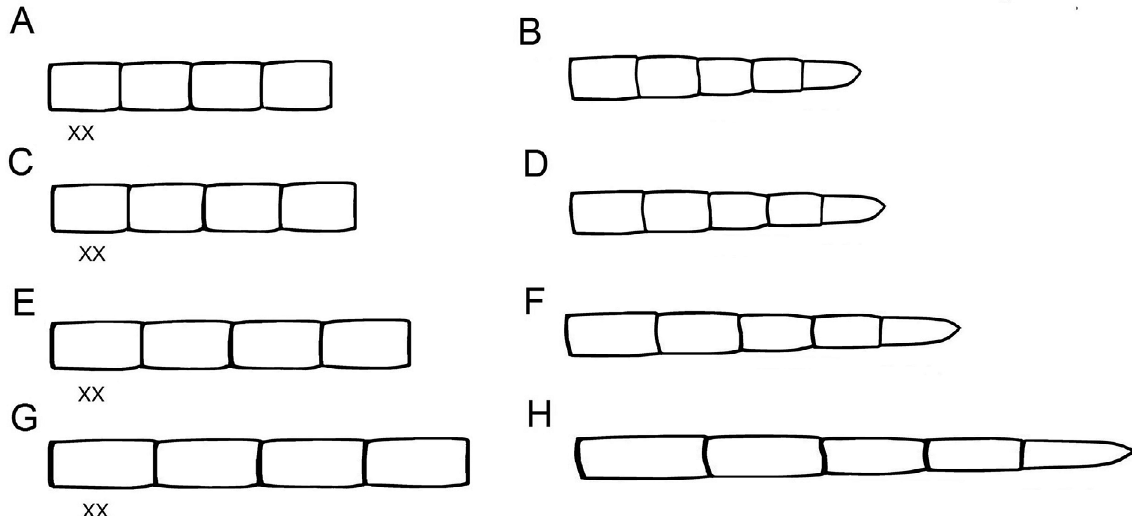
Fig. 3. Central and apical flagellomeres. A–B . Enicospilus cerebrator Aubert, 1966. C–D . E. cederbergi sp. nov., paratype, ♀ (NHRS-HEVA000008148). E–F . E. adustus (Haller, 1885). G–H . E. ryrholmi